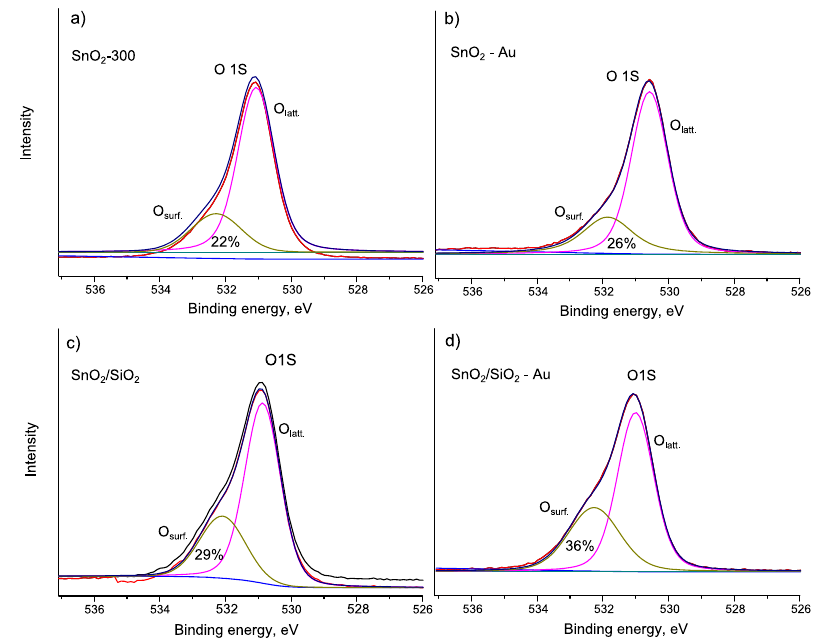
/ SiO / SiO 2 and ( d ) SnO 2 2